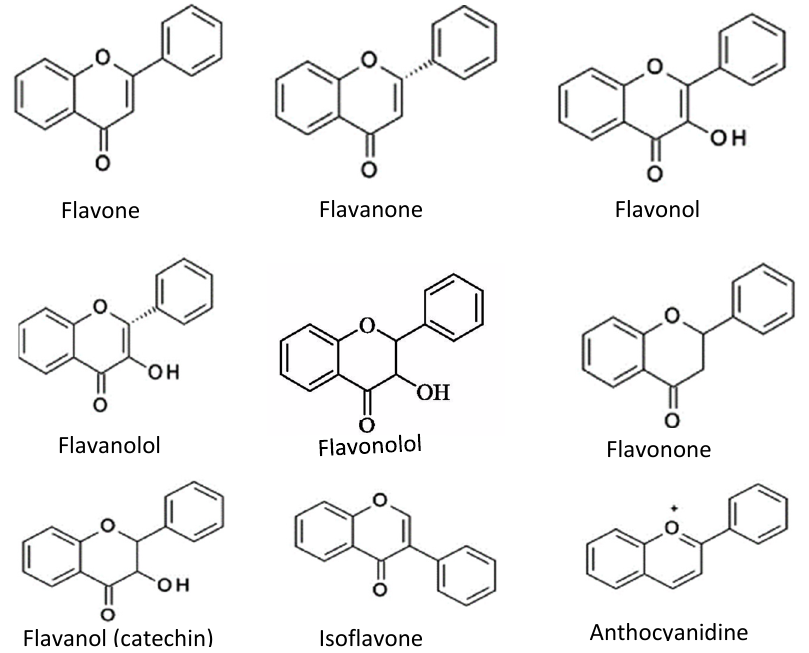
Figure 3. Chemical structures of common flavonoids.